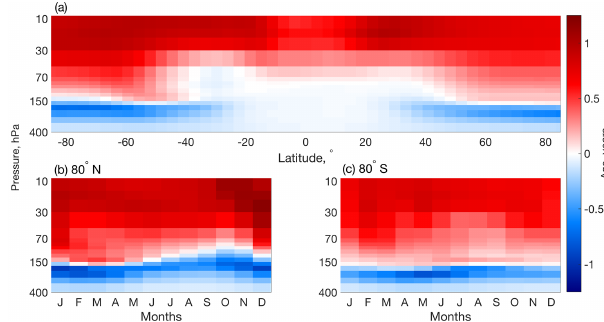
Figure 2. A comparison of the age of stratospheric air in the free- running CMAM and CMAM30 averaged between 2004 and 2010. (a) The zonal mean difference of the CMAM30 mean age subtracted from the free-running mean age (years) and the monthly time series difference (b) at 80 ◦ S and (c) at 80 ◦